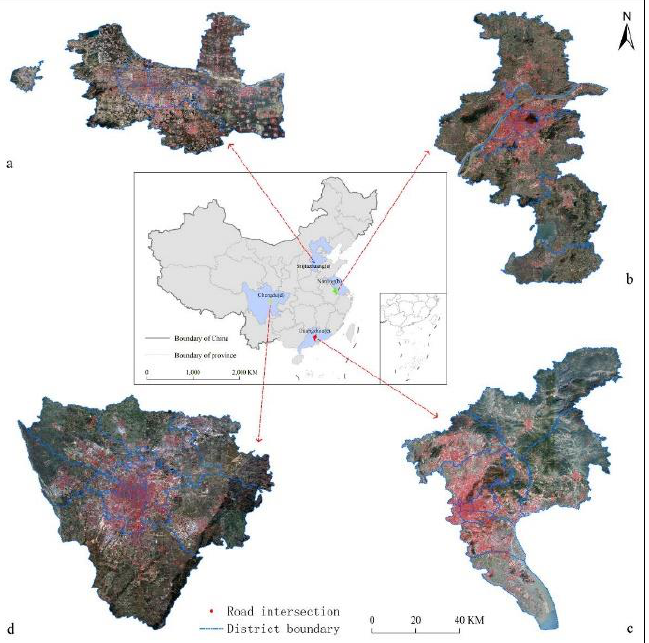
Figure 1. The study area of Shijiazhuang ( a ), Nanjing ( b ), Guangzhou ( c ), and Chengdu ( d ).